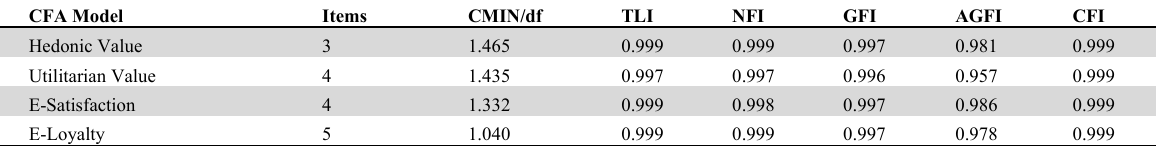
Confirmatory factor analysis of all measurement